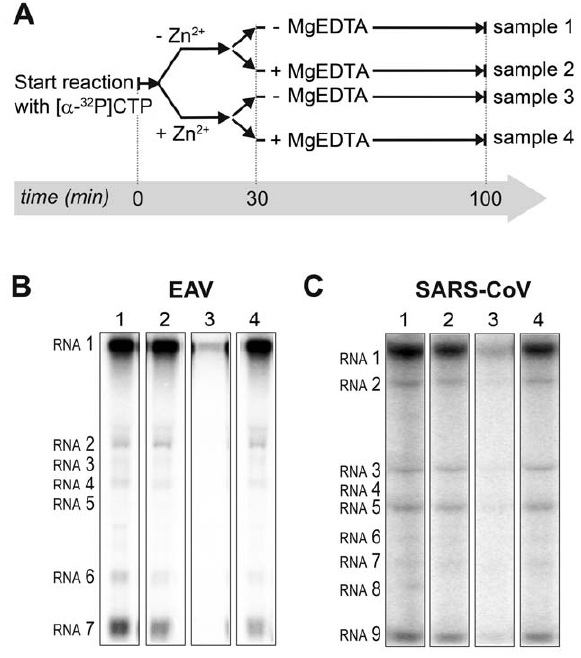
Figure 3. Inhibition of nidovirus RTC activity by Zn 2 + can be reversed by chelation. ( A ) Schematic representation of the in vitro assays with isolated RTCs, which were initiated with [ a - 32 P]CTP, either in the absence (sample 1 and 2) or presence of 500 m M Zn 2 + . After a 30- min incubation at 30 u C, both the untreated and Zn 2 + -treated samples were split into two aliquots, and 1 mM of the Zn 2 + chelator MgEDTA was added to samples 2 and 4. All reactions were subsequently incubated for another 70 min before termination. ( B ) Analysis of RNA products synthesized in assays with EAV RTCs. Numbers above the lanes refer to the sample numbers described under (A). ( C ) In vitro activity assay with SARS-CoV RTCs.